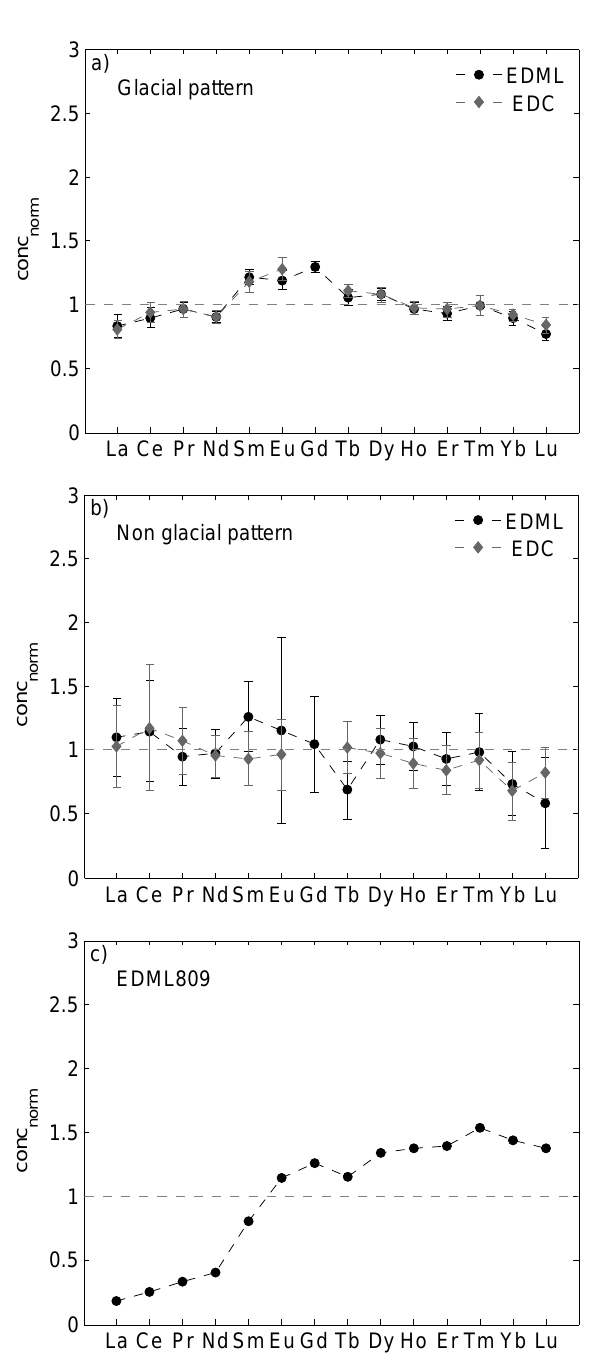
Fig. 3. Mean REE pattern from 27000 to 15200yrBP (a) and 15200 to 7500yrBP (b) . Error bars indicate the 1 σ standard devi- ation of the variability for each REE. Much higher sample hetero- geneity is clearly identifiable during the Holocene compared with the LGS and early transition, which is, in part, due to the low con- centrations. The graph (c) displays a pattern with a strong enrich- ment in HREE, from the depth interval containing the thickest vol- canic ash layer in the whole EDML ice